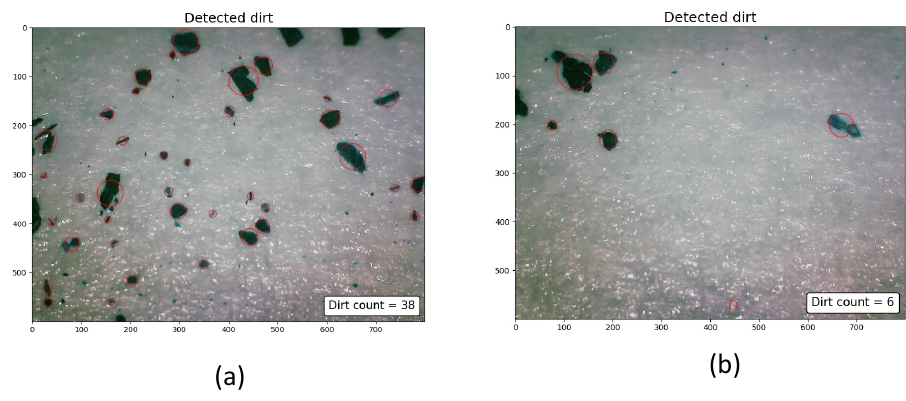
Figure 7. The dirt particles gathered from a dense dirt accumulated region ( a ), the dirt particles gathered from a sparse dirt accumulated region ( b ).